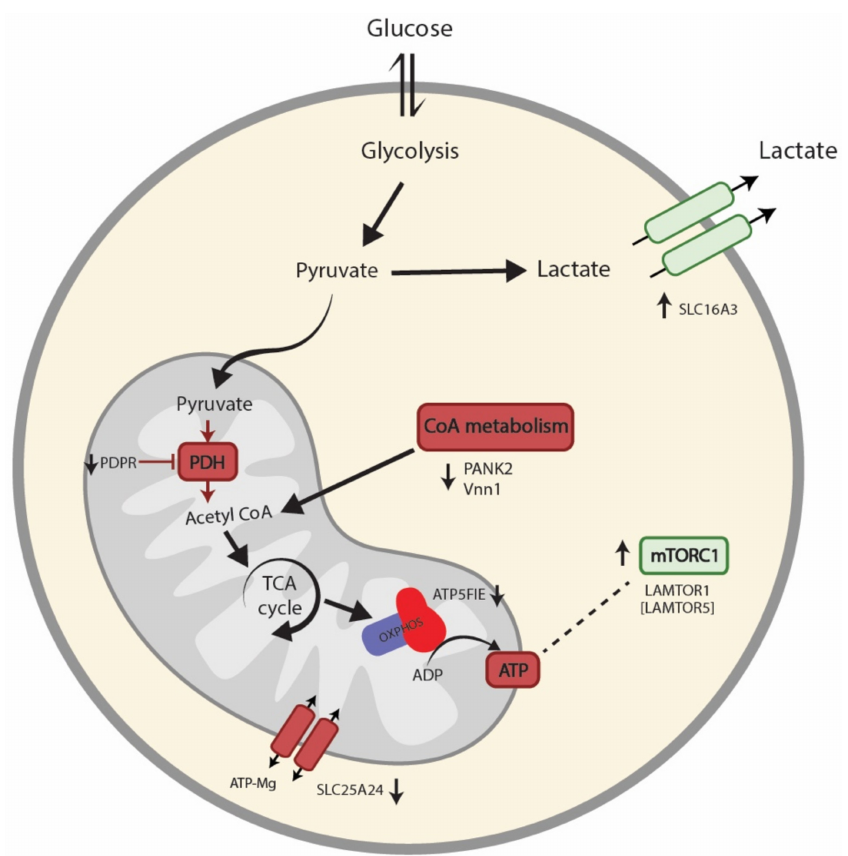
Figure 4. Summary of proteomics findings in PBMCs from ME/CFS patients and healthy